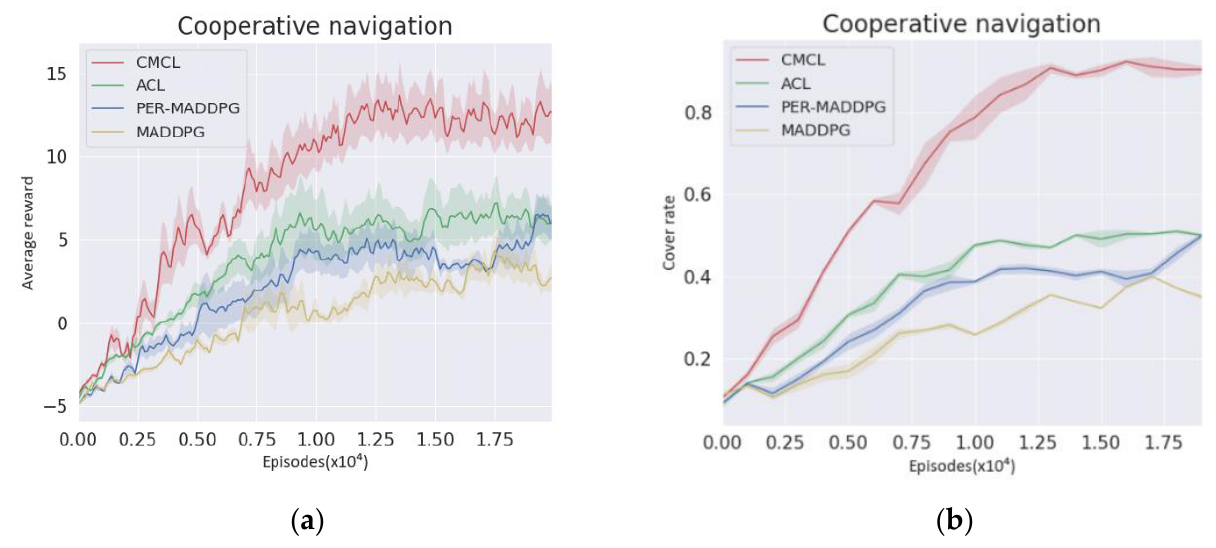
Figure 7. Cooperative navigation experimental environment.